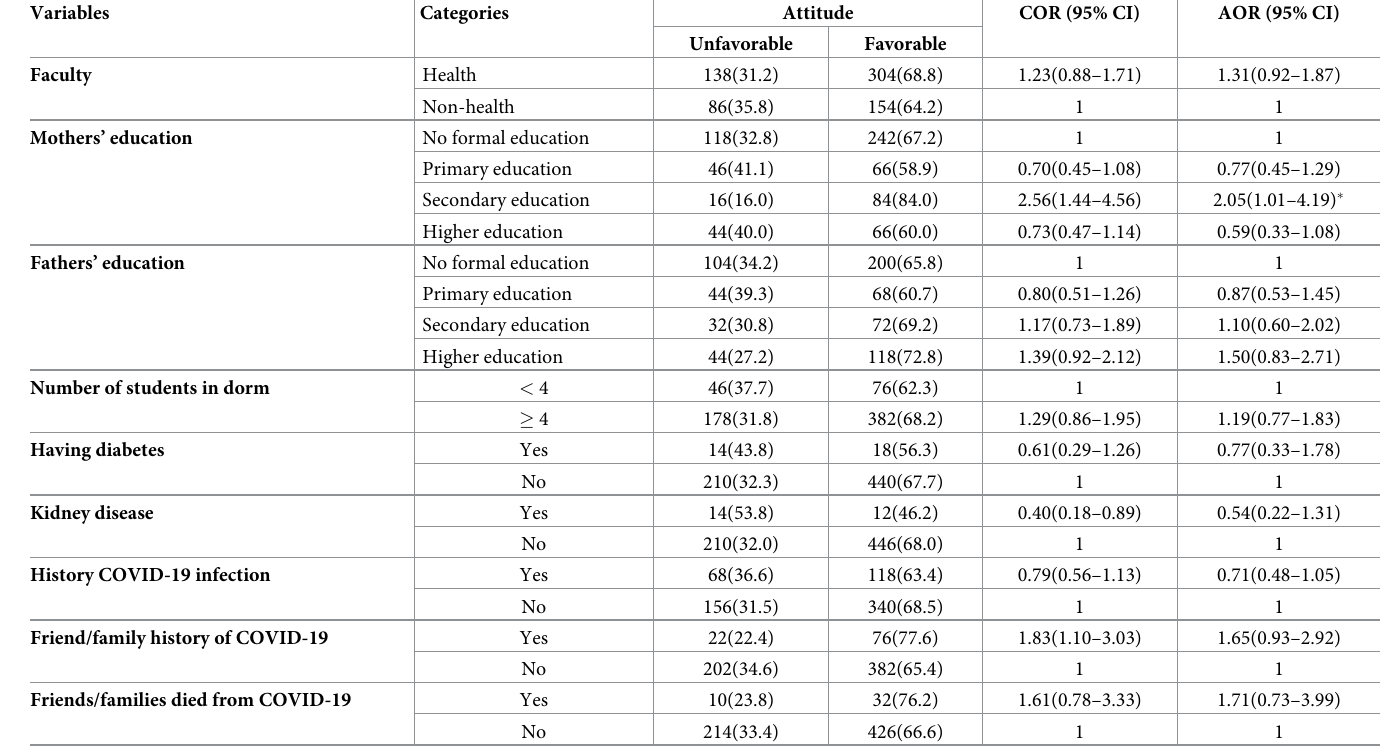
Table 6. Univariable and multivariable logistic regression analysis for attitude towards COVID-19 prevention measures in DBU, Northeast Ethiopia, 2020.